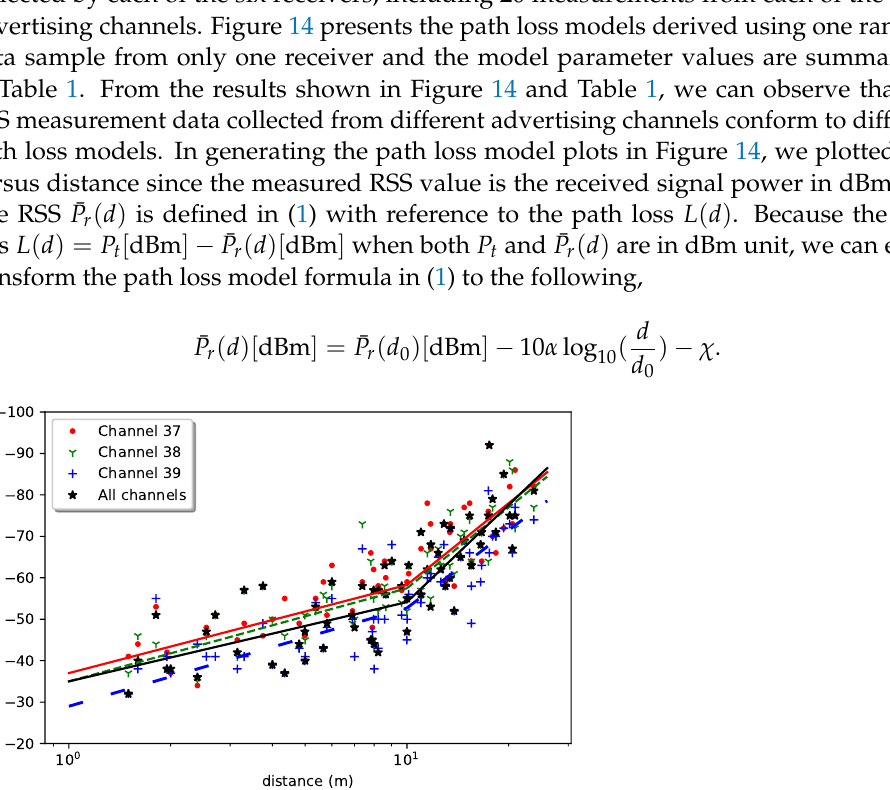
Figure 14. Two-segment path loss models derived using one random data sample from only one